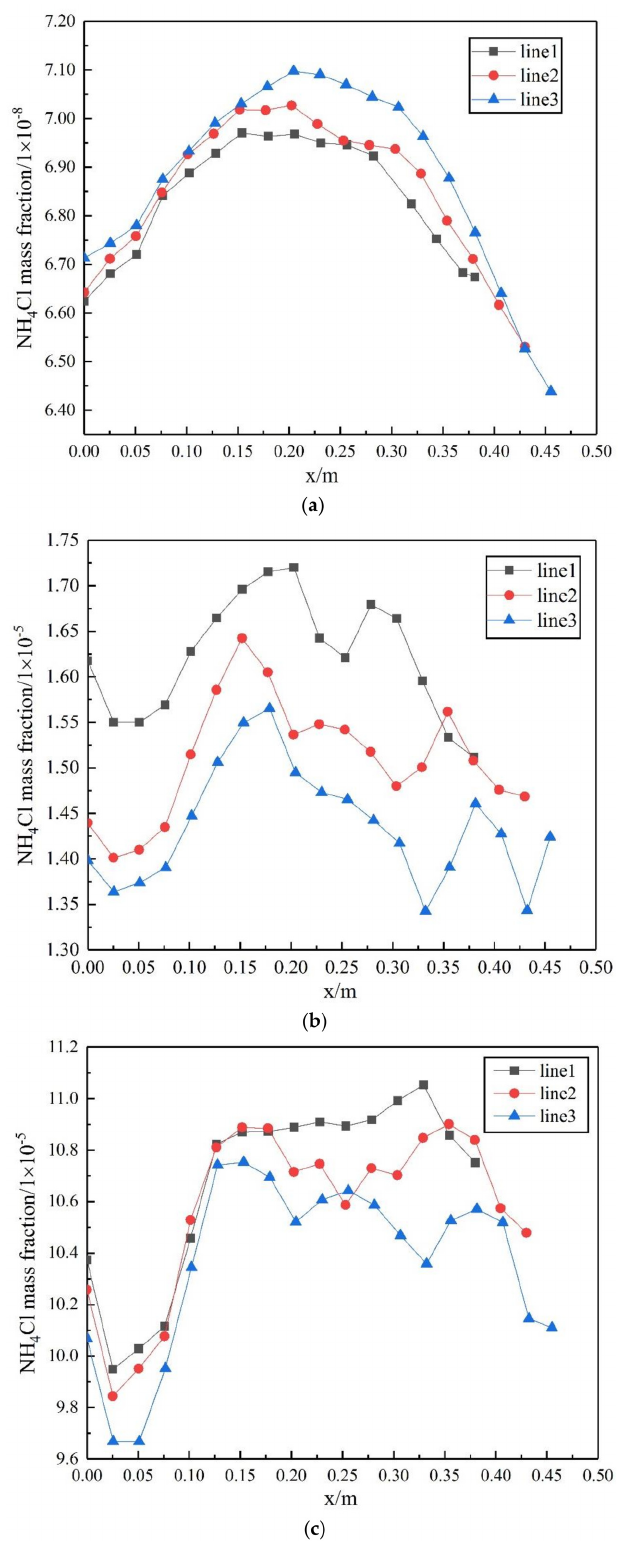
Figure 24. Distribution of the crystallization amount of ammonium chloride in tube bundles in different stages: ( a ) initial stage of calculation, ( b ) middle stage of calculation and ( c ) late stage of